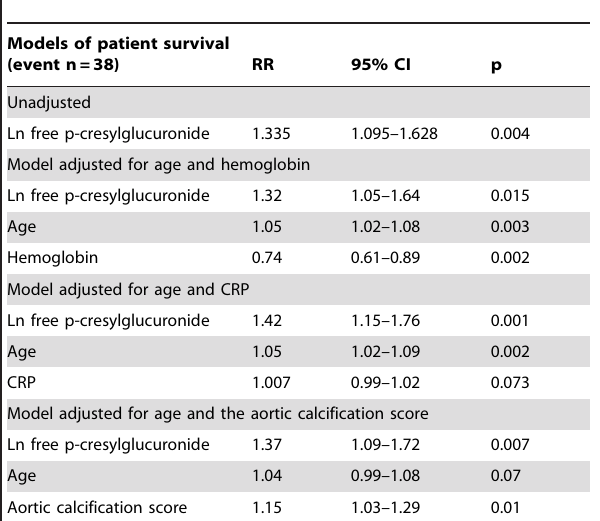
Table 5. Univariate and multivariate Cox regression analyses of risk factors at baseline for cardiovascular mortality, with free p-cresylglucuronide entered as a continuous variable in all patients (n= 139).